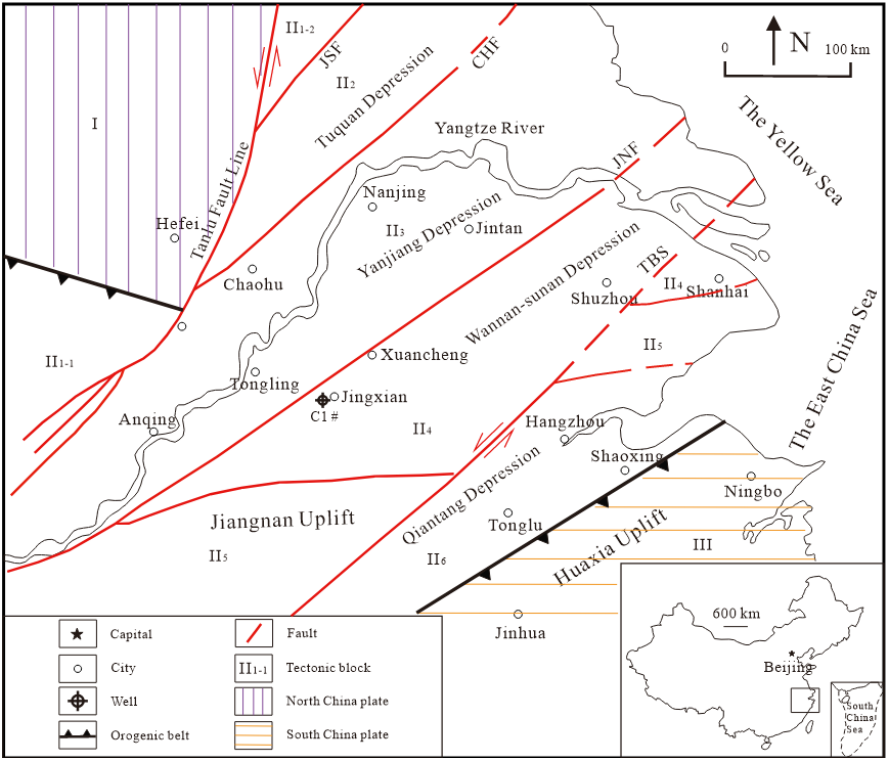
Figure 1. The tectonic location diagram of the Lower Yangtze area and sampling location (modified from Zhu et al. [37]). JSF: Jiashan-xiangshui Fault; CHF: Chuhe Fault; JNF: Jiangnan Fault; TBS: Tianmushan-baijishan Shear Zone.